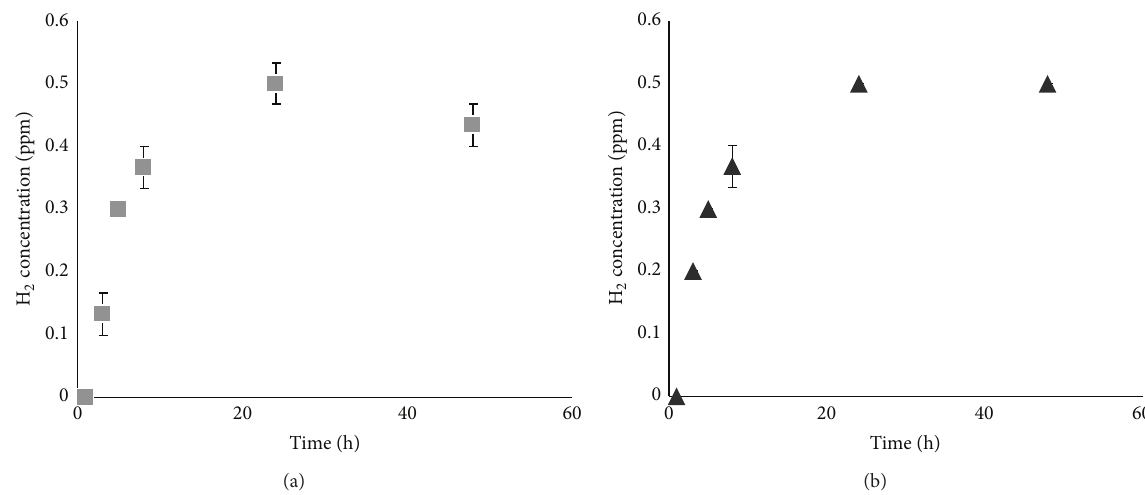
Figure 2: Measurement of hydrogen concentration in OCT preservation solution after hydrogen electrolyzer treatment. (a) DMEM. (b) UW solution. Each data point represents the mean and error bars show the SE.